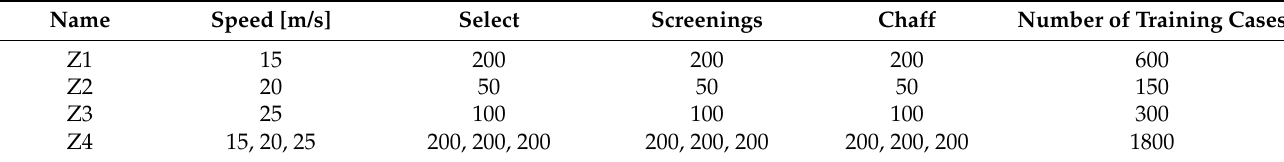
Table 1. The distribution of the frequency of training cases depending on the sowing speed and the type of triticale